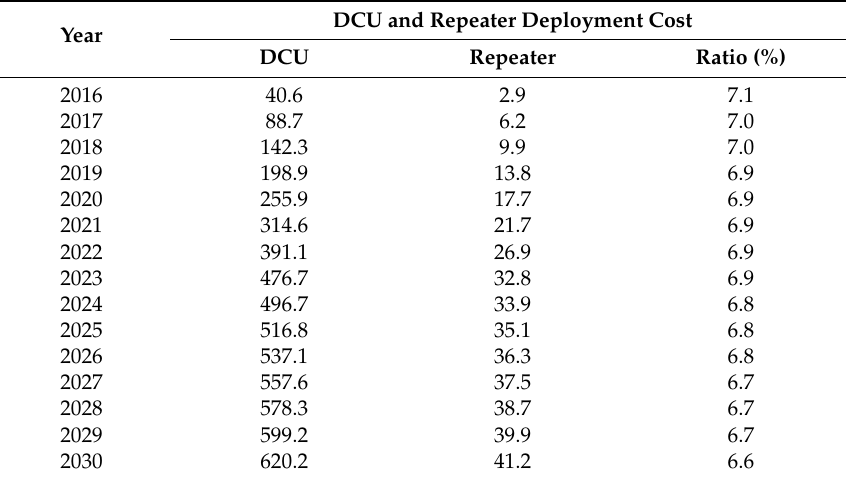
Table 9. Comparison of Communications Modem Cost Results per Deployment Method.